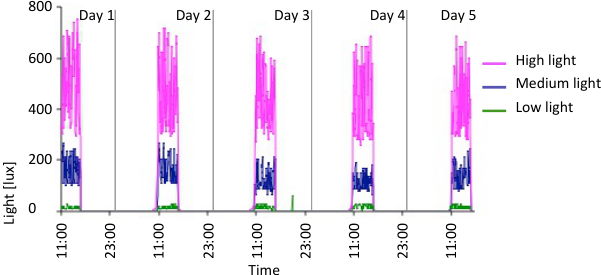
Figure 6. Five-day plot of light levels taken from HOBO loggers in October 2012 in 10 ◦ C tank. Pink is high light, blue is medium light, and green is low light.